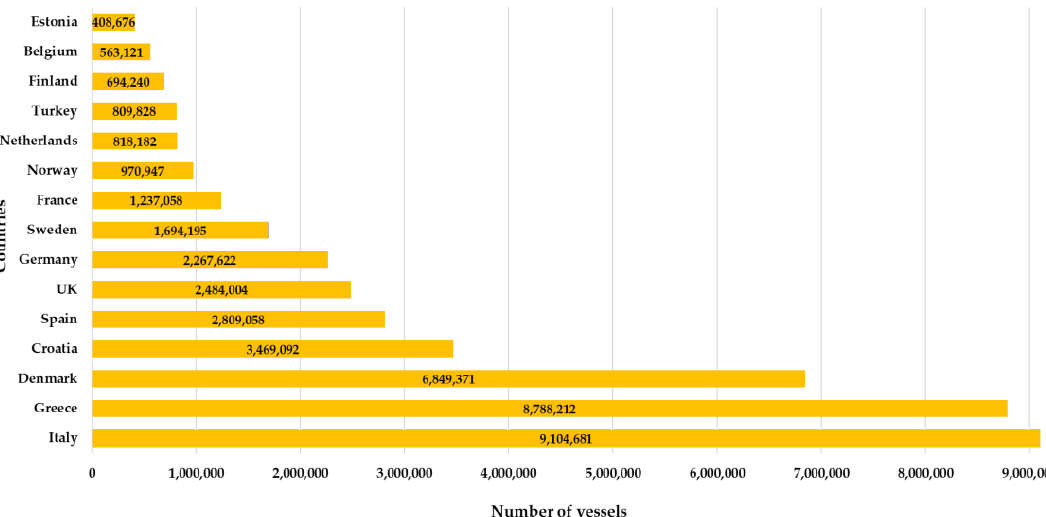
Figure 4. Top 15 European countries regarding the number of vessels registered in the period 2001 – 2020.